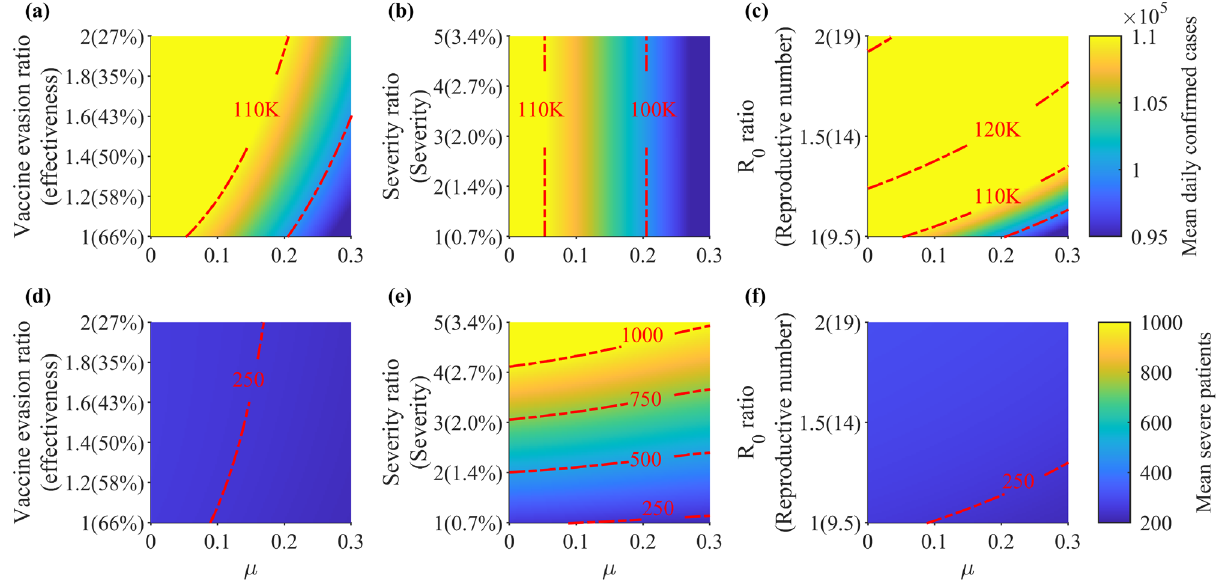
Figure 6. Simulation results characterizing new variants given varying vaccine evasiveness, disease severity, and R 0 from December 2022 to June 2023 and µ ∈ ( 0, 0.3 ) . Vaccine evasion ratio of 1 means that the vaccine effectiveness against the variant is the same as the original Omicron variant, while a ratio of 2 means that vaccines are 27% effective against the new variant. The severity and R 0 ratios indicate the ratio of severity rates and transmissibility of the new variant compared to the original Omicron variant. Panels ( a–c ) show the mean daily incidence, and panels ( d–f ) show the mean severe patients. The red dotted curves indicate the contours of the